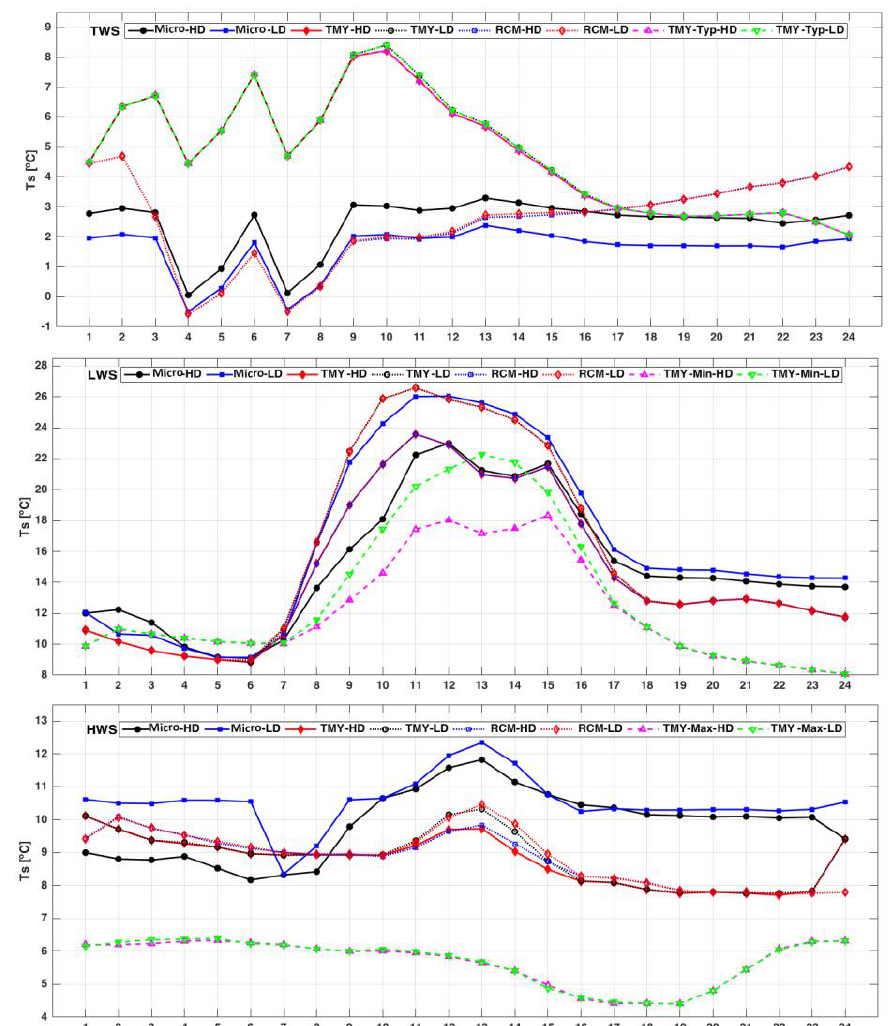
Figure 7. Hourly 𝑇 𝑠 of all elevations of the central building in the LD and HD areas adopting fifteen weather datasets. TWS: 19 February; LWS: 4 October, HWS: 15 January; TMY-Typ: 14 September; weather datasets. TWS: February 19th; LWS: October 4th, HWS: January 15th; TMY-Typ: September TMY-Min: 17 November, and TMY-Max: 13 January. HD: High density; LD: Low 14th; TMY-Min: November 17th, and TMY-Max: January 13th. HD: High density; LD: Low density.